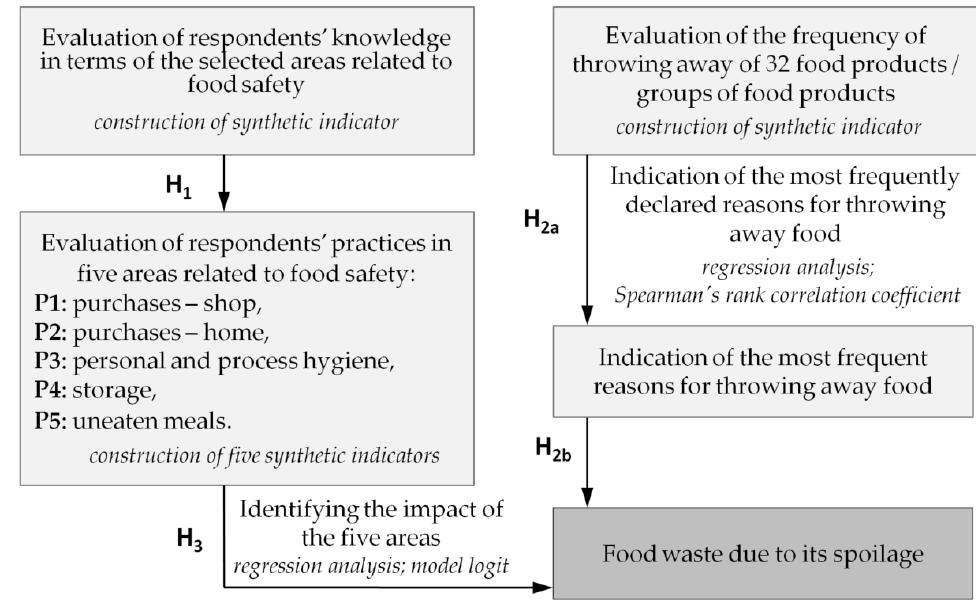
Figure 1. The conceptual research model adopted in the work.